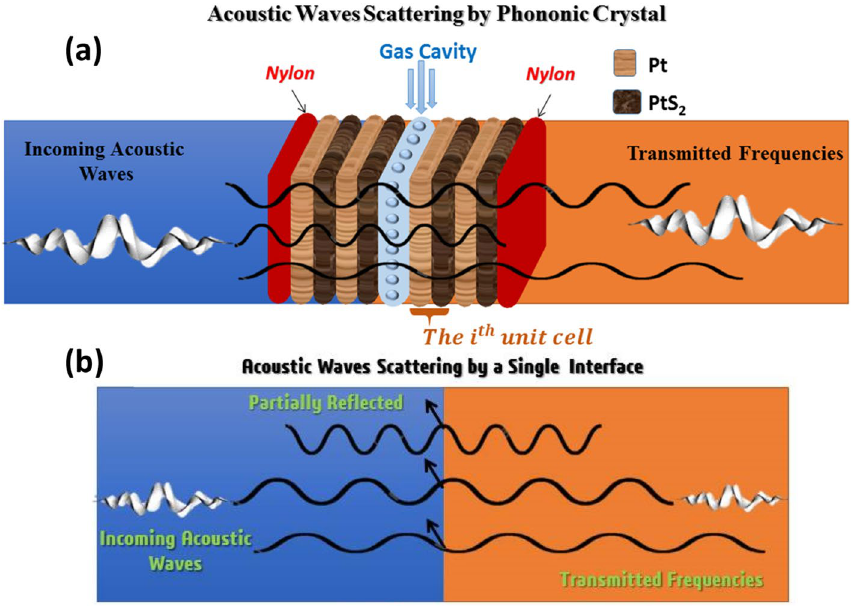
Figure 1. ( a ) The Mechanism of interaction acoustic waves through PhC greenhouse gas sensor structures, ( b ) the attenuation of the incident acoustic waves within the interface between two layers of the structures.